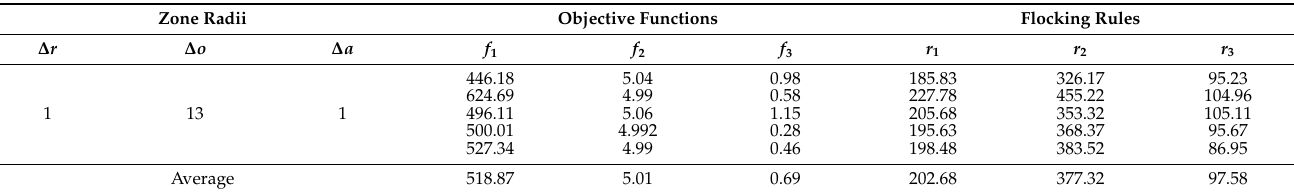
Table A4. Results of testing perception zones for flocks with 100